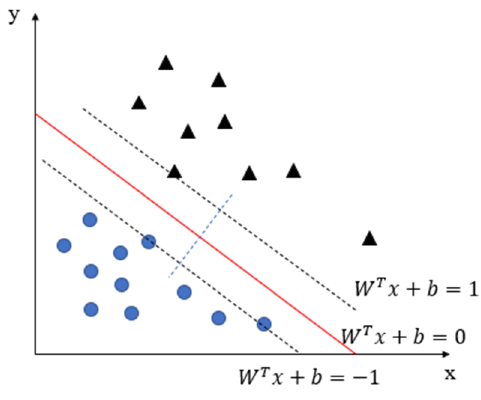
Figure 7. Linear SVM model.